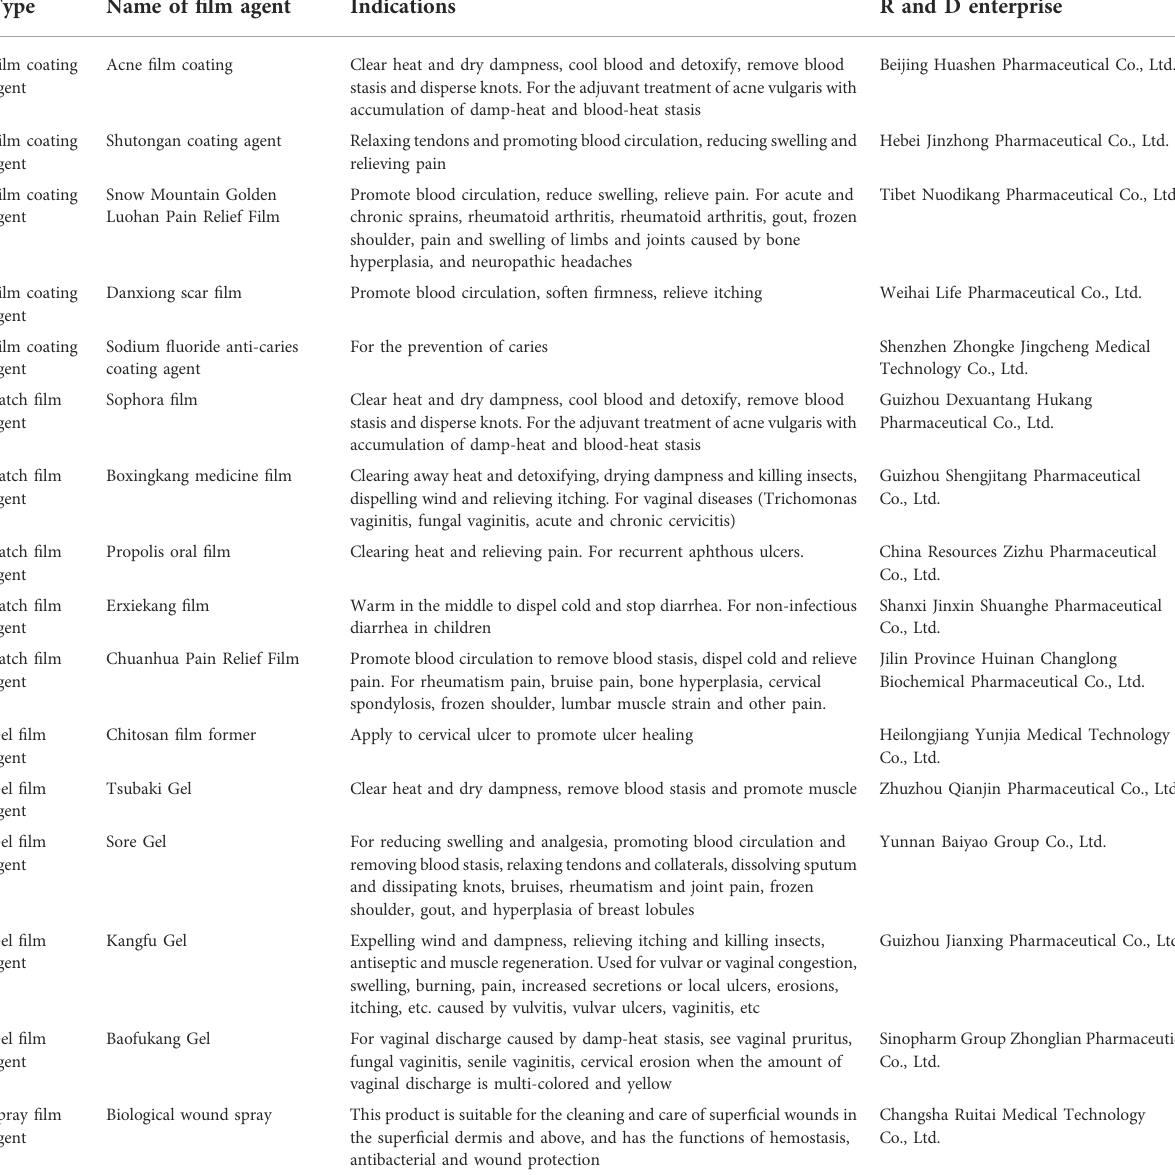
TABLE 1 The number of Chinese medicine fi lm preparations in the article and their main